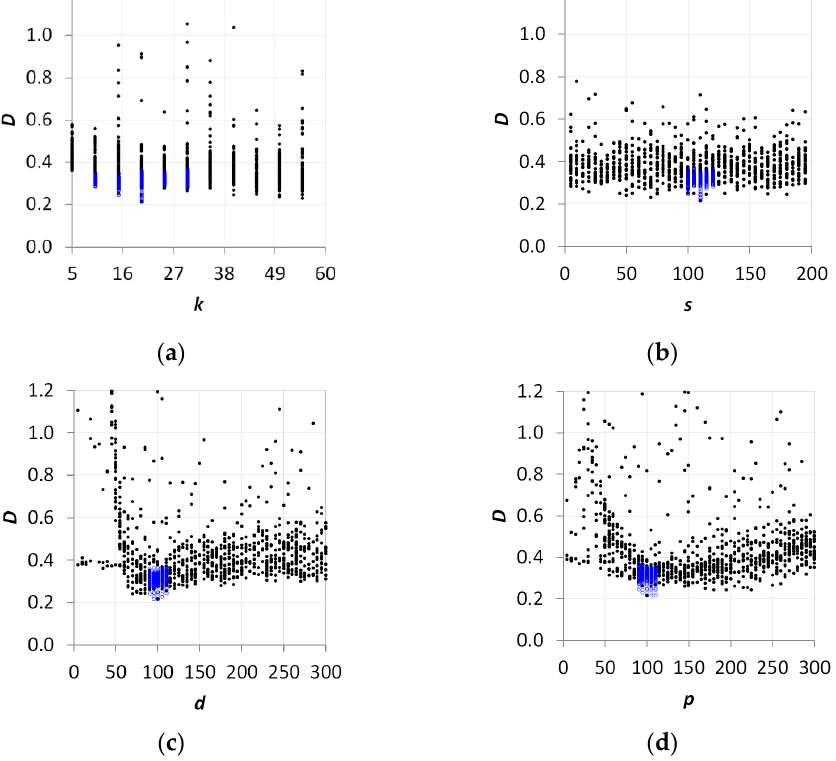
Figure 5. Segmentation parameters optimized on reference areas in the arid period (black dots represent values resulting from the rough; blue dots represent values resulting from the fi- ne-tuning): ( a ) D versus k ; ( b ) D versus p ; ( c ) D versus s; ( d ) D versus d , dispersions.